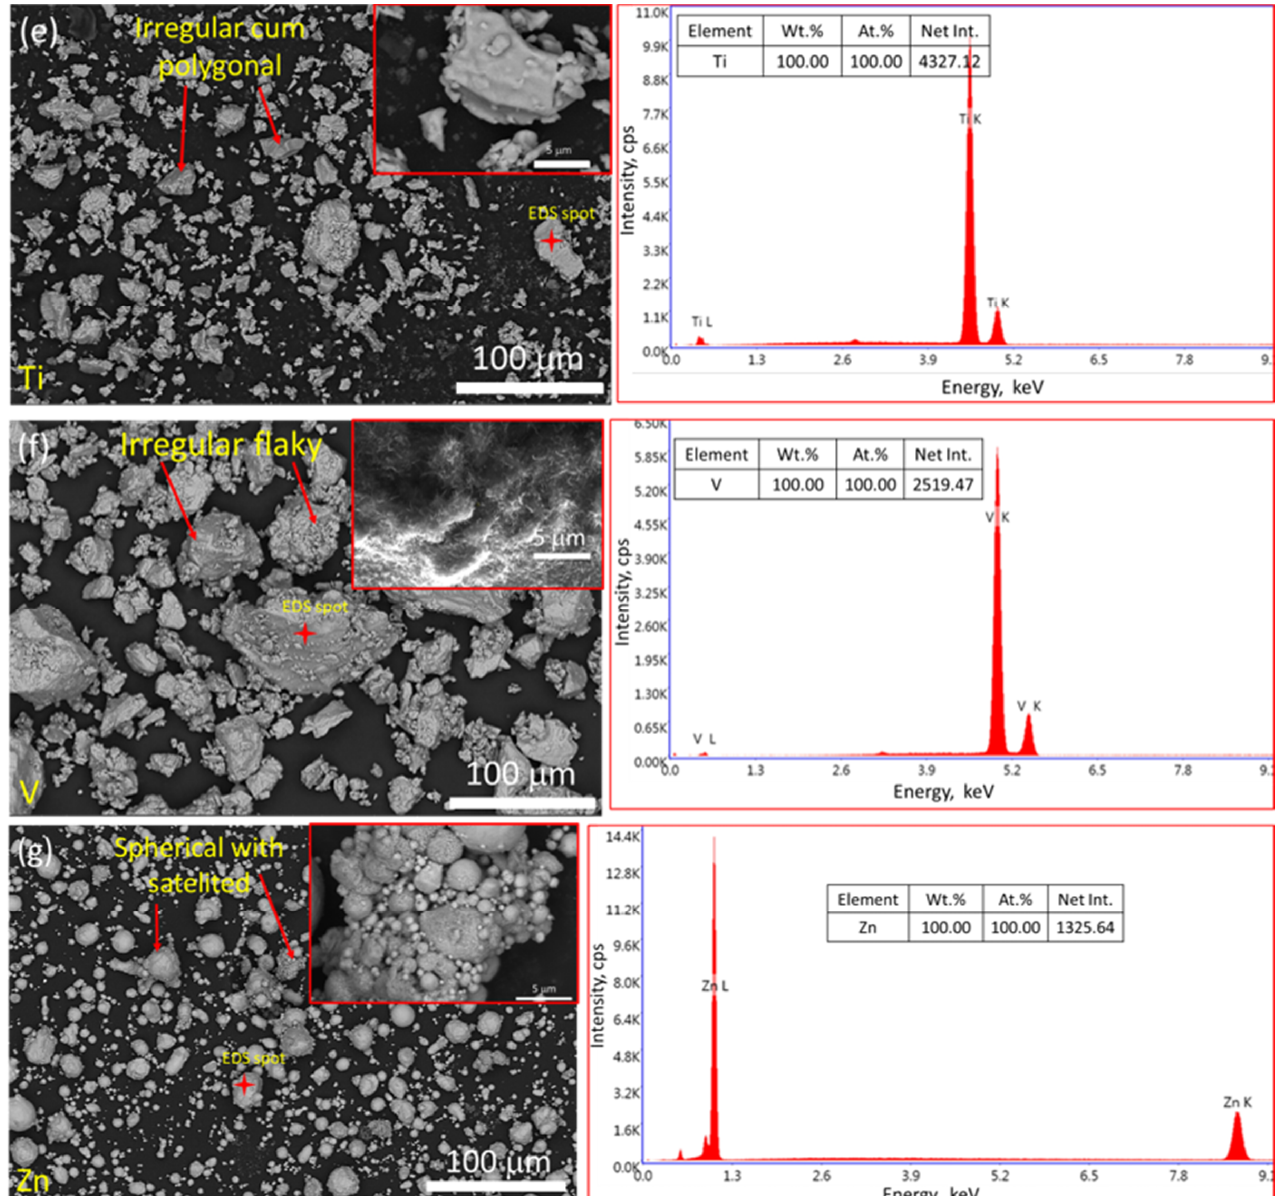
Figure 3. HRSEM powder surface morphology of as-received elemental powders: ( a ) Fe-irregular shape; ( b ) Cr-Platelet shape; ( c ) Cu-different size spherical shape; ( d ) Mn-different size polygonal shape; ( e ) Ti-irregular cum polygonal shape; ( f ) V-irregular; ( g ) Zn-spherical with satellite. Top right inset images describing the morphology of as-received particles at higher magnification. Right side of each image illustrating the EDS spot analyses for checking the purity of as-received elemental powders.